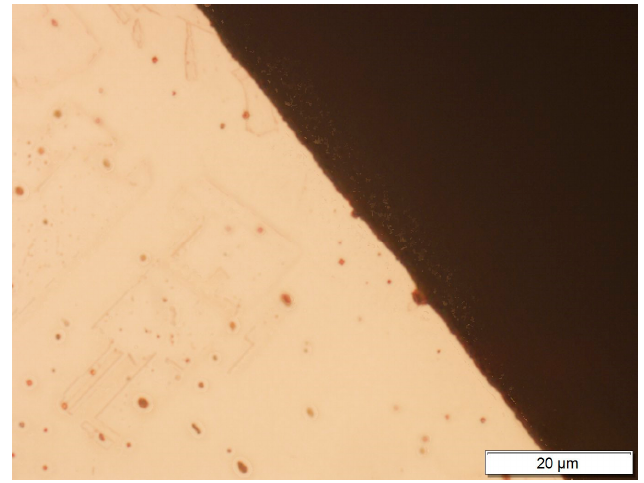
Figure 6. Gold electrode photography.